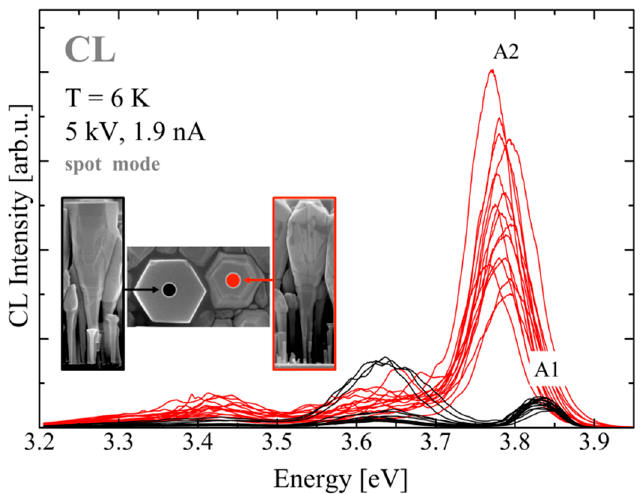
Figure 8. Series of cathodoluminescence spectra collected in the spot-mode using AV = 5 kV, where only the top (p-type) part of the structure is excited. Differences between NWs with flat hexagonal tops (black curves) and irregular ones (red curves) are clearly visible. The inset shows the geometry of the measurements.